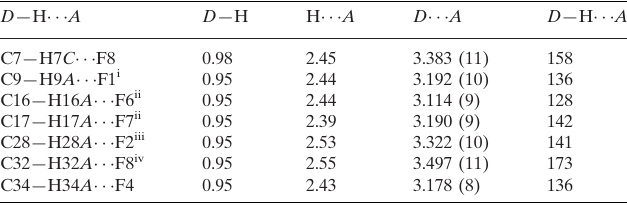
Hydrogen-bond geometry (A˚ , (cid:4)